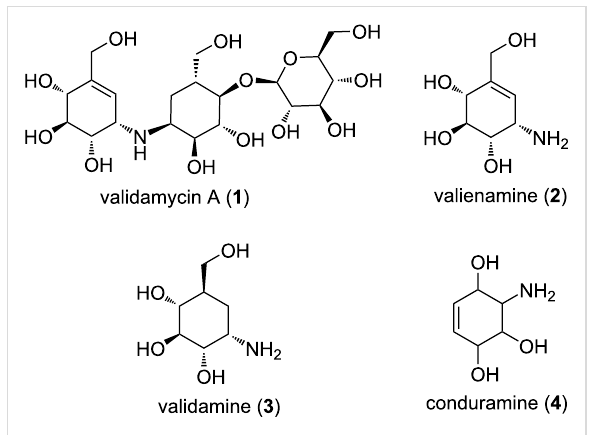
Figure 1: Structures of some important aminocyclitols.